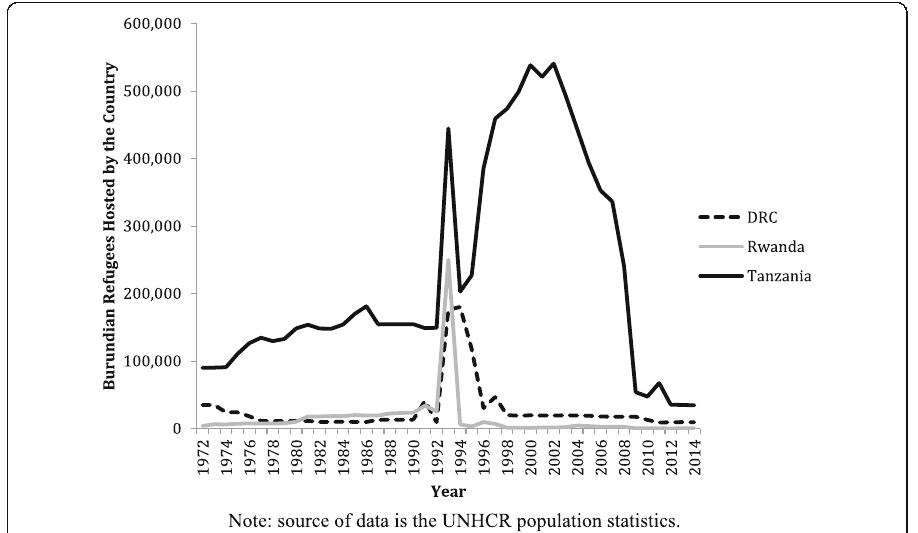
Fig. 1 Burundian refugees in DRC, Rwanda and Tanzania. Source of data is the UNHCR population